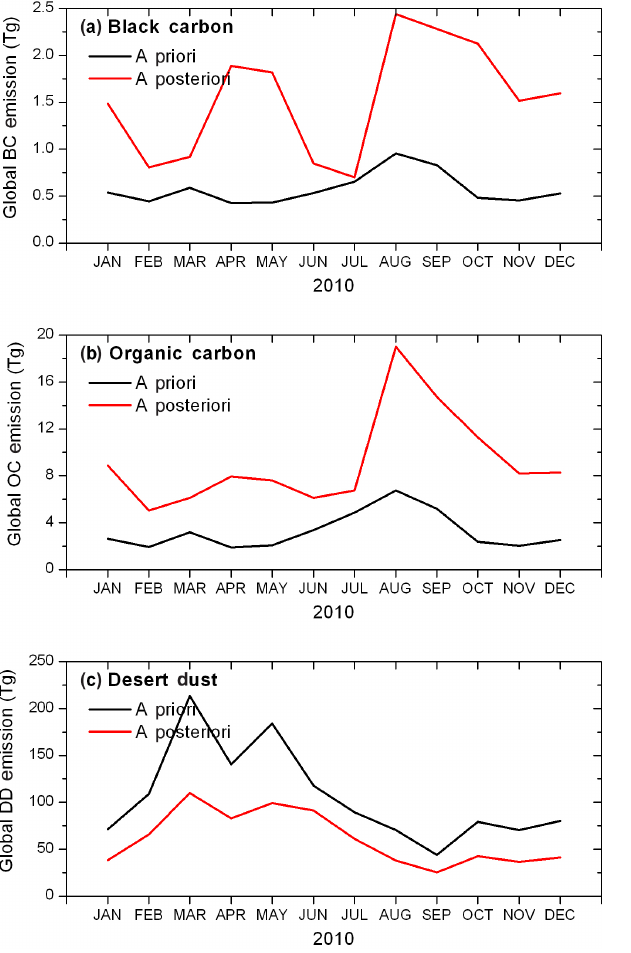
Figure 3. Comparison of monthly emissions for a priori and a pos- teriori datasets: (a) BC emissions, (b) OC emissions and (c) DD emissions.